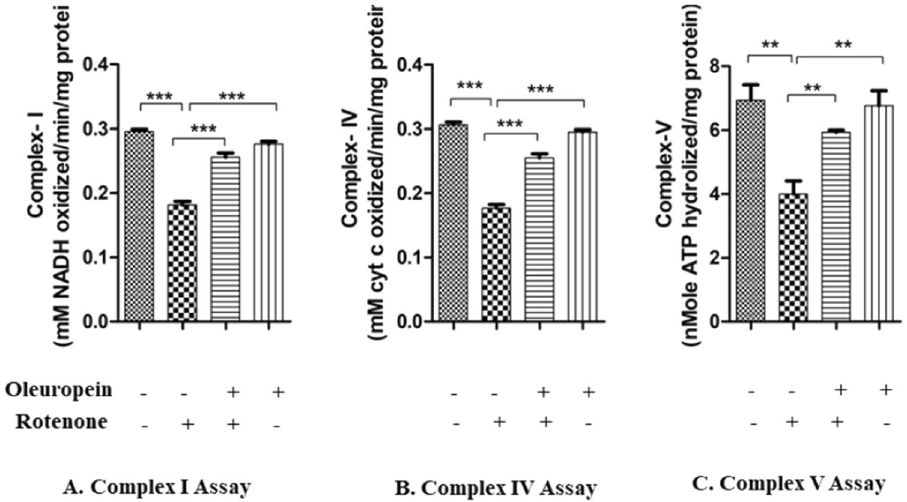
treatment group, significantly increased mitochondrial complexes activity of I, IV and V was observed. The results are provided as mean SEM (n = 5). **p < 0.01, and ***p < 0.001. The mean ± SEM (n = 6) is used to depict the values.